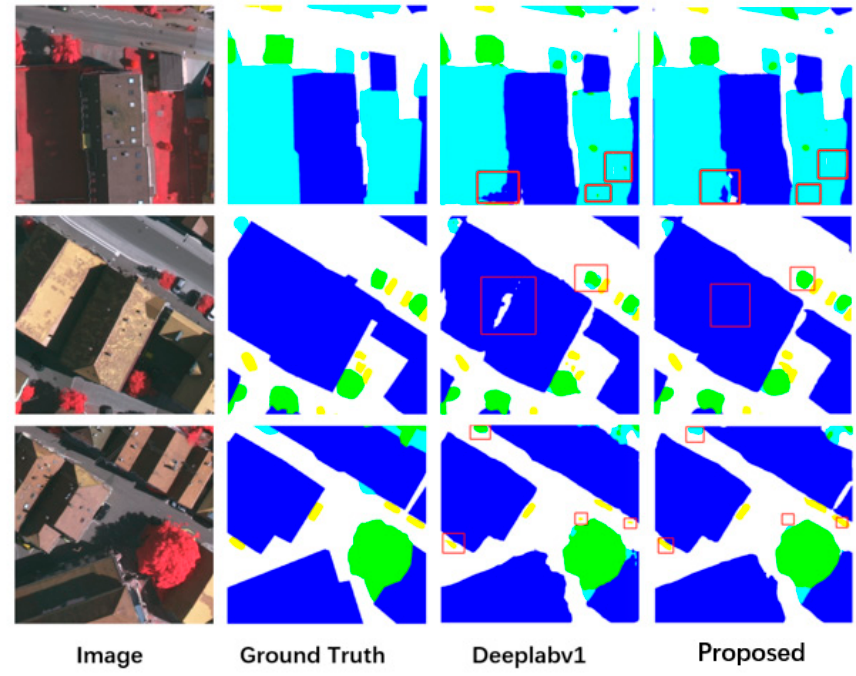
Figure 5. Examples of semantic segmentation results from the Vaihingen. (ground truth, the label published by the publisher of the open dataset).